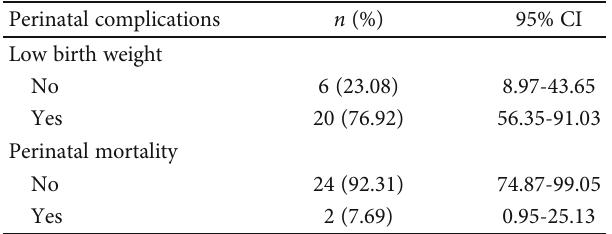
Table 3: Perinatal complications of congenital malaria ( N = 26